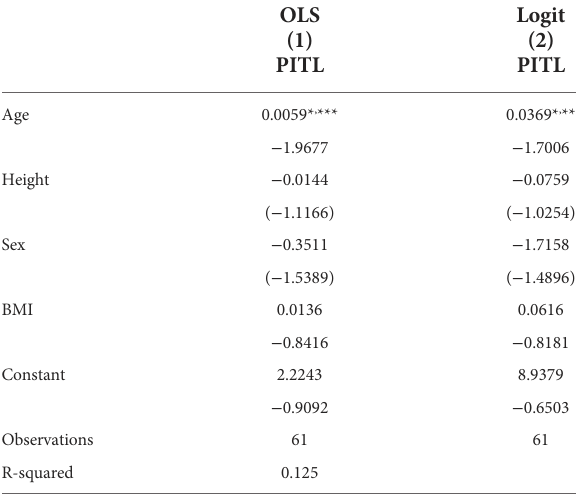
TABLE 5 Regression